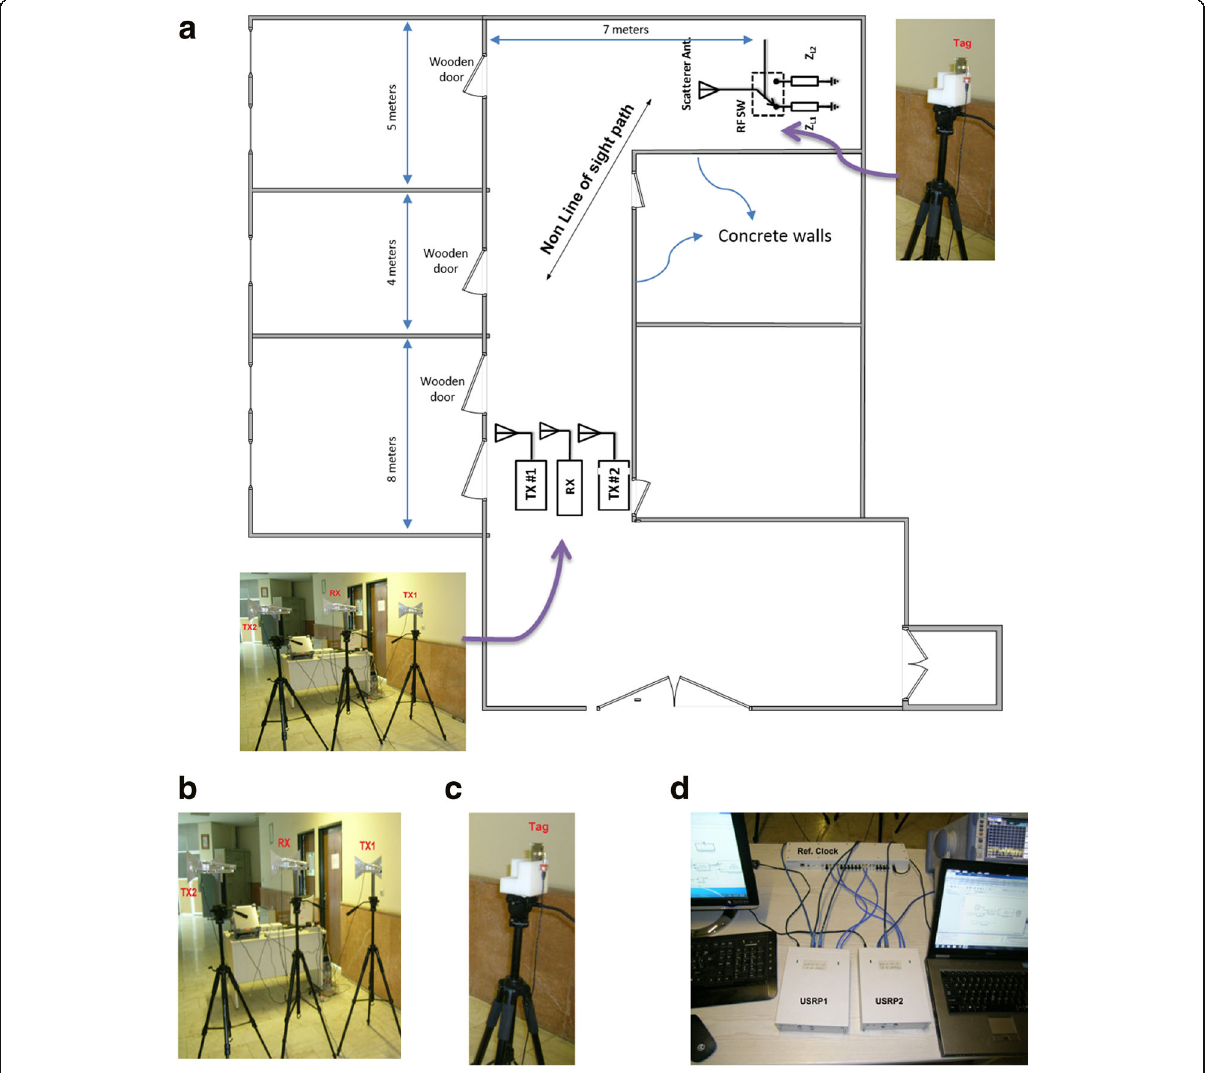
Fig. 7 Backscatter implementation setup using two transmitter query scheme a The plan of the indoor measurement environment, b two transmit query and receiving antennas, c tag antenna d transmitter and receiver radios based on USRP N210 modules and clock reference